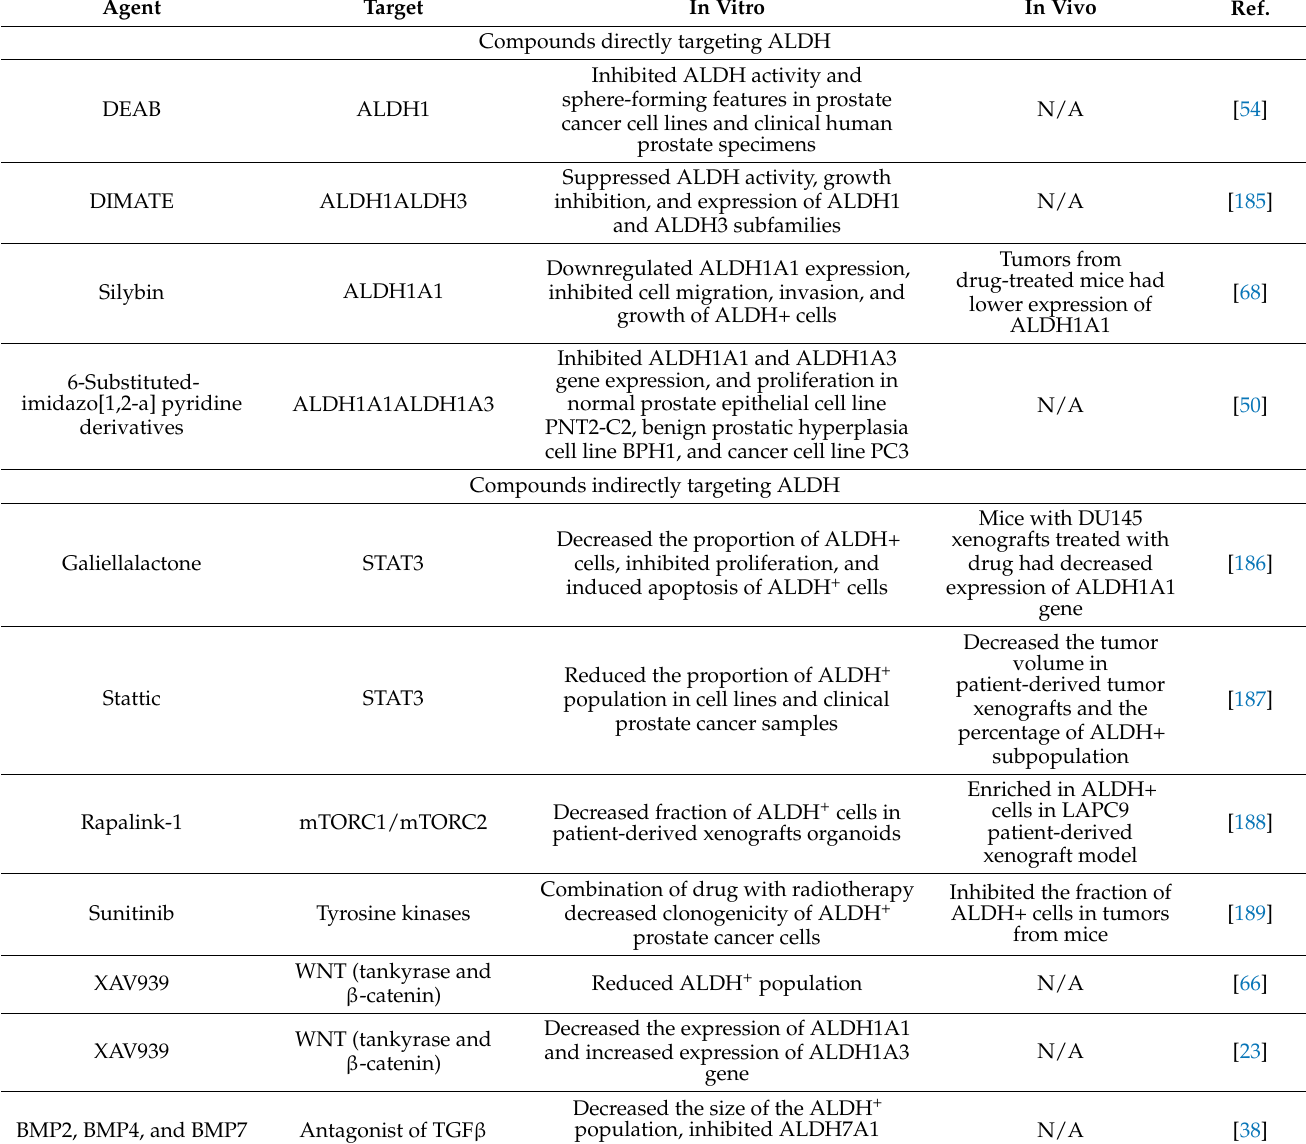
Table 2. Compounds targeting ALDH in prostate